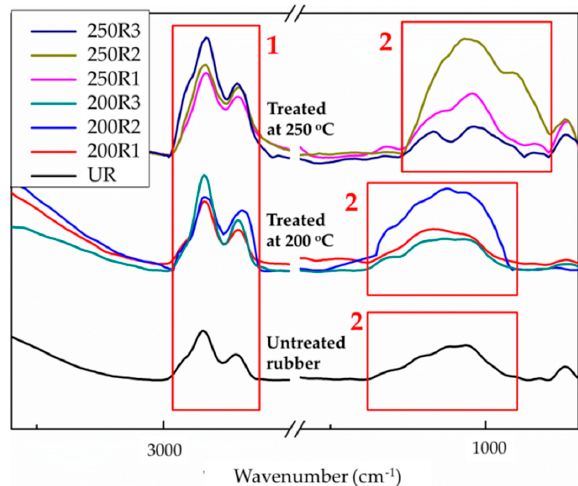
Figure 5. IR spectra of the crumb rubber treated at 200 °C and 250 °C. R1: air/nitrogen flow = 1/0, R2: air/nitrogen = 1/4, R3: air/nitrogen flow = 0/1, UR: as-received rubber. *1: C–H stretching, 2: SOx stretching [33].